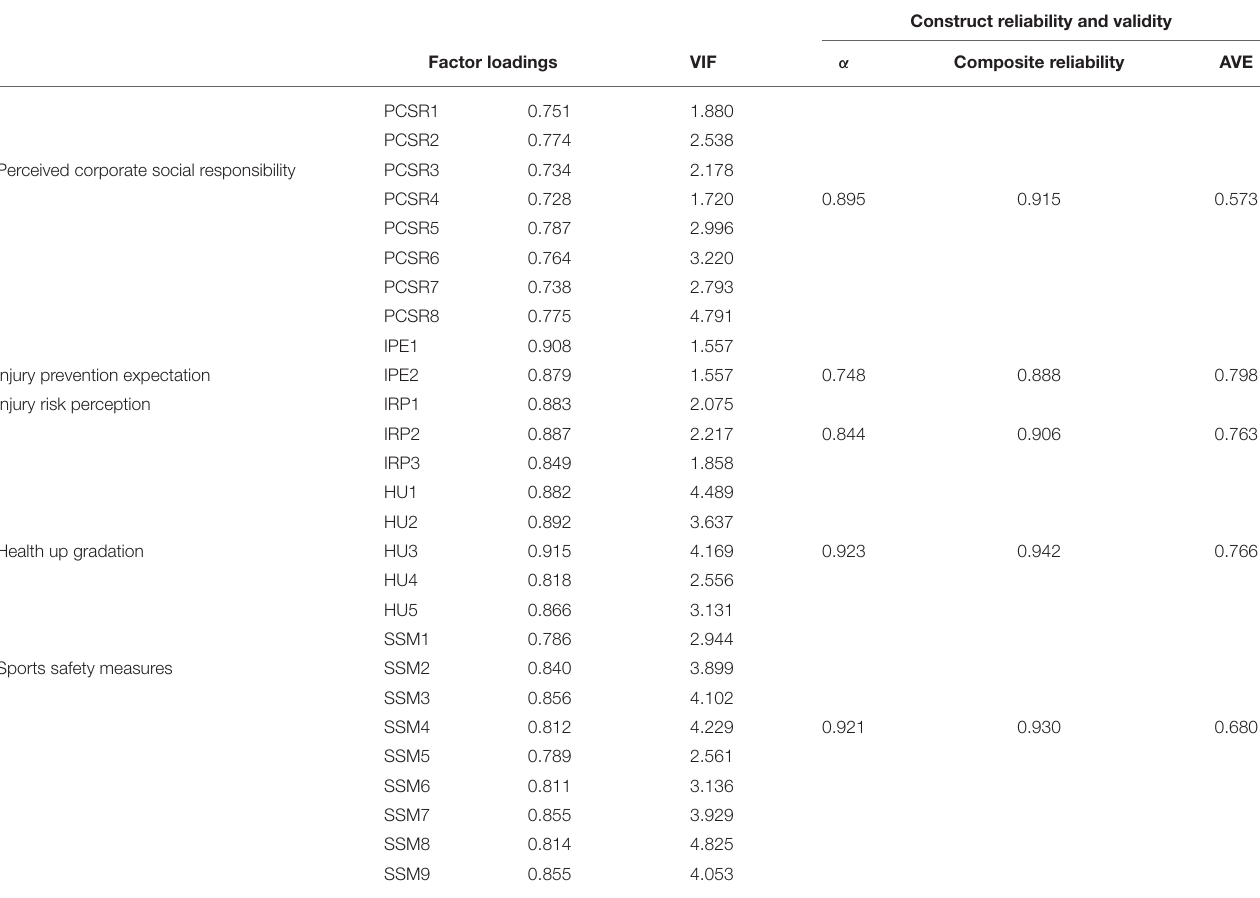
TABLE 2 | Model assessment (Direct Model).